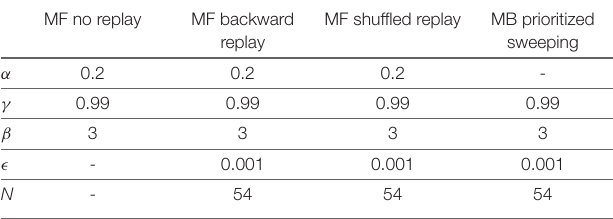
TABLE 1 | Algorithm parameters used to generate the results in this